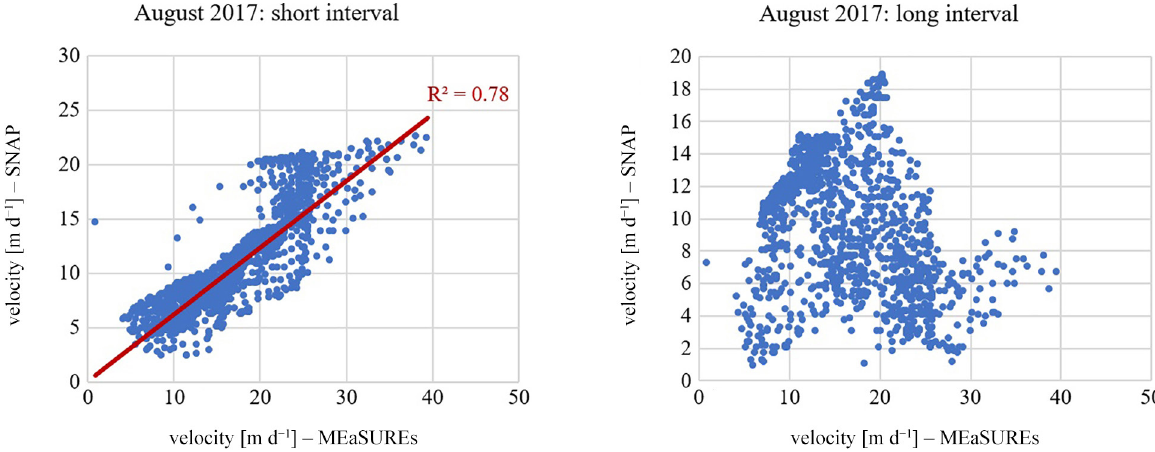
Fig. 7. Correlation plots for